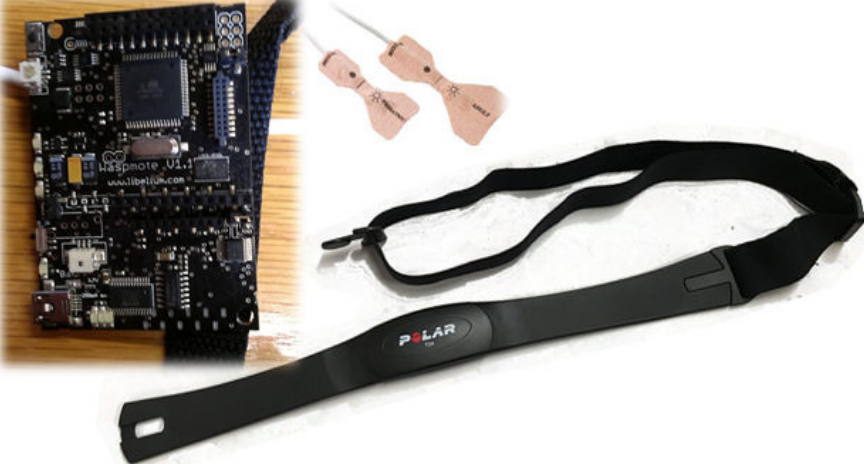
Figure 17. Hardware devices involved in the monitoring process.